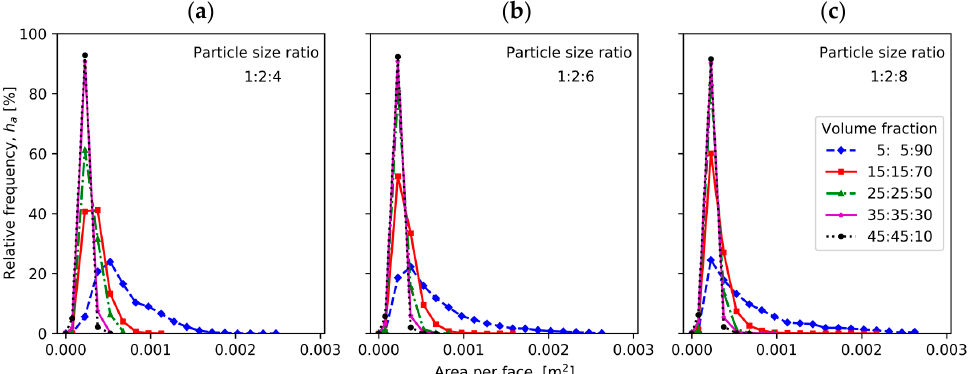
Figure 6. Relative frequency of area per face of radical Voronoi cells for samples having di ff erent volume fractions and three instances of particle size ratio: ( a ) 1:2:4, ( b ) 1:2:6 and ( c ) 1:2:8.